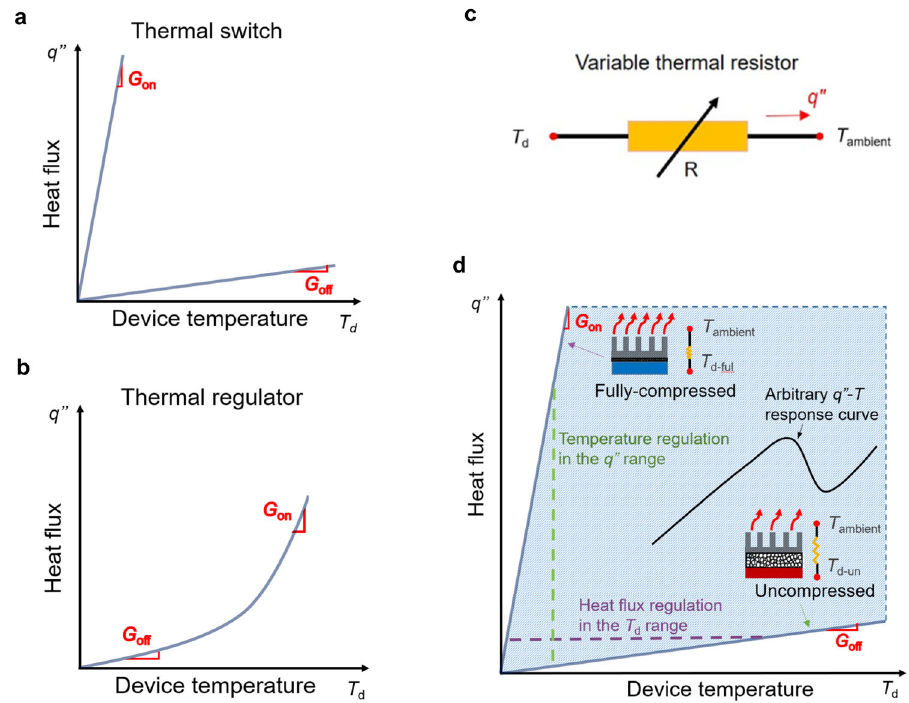
Fig. 1 Working principle of thermal devices in tradition and in this work. a A traditional thermal switch only has two possible thermal conductance states and b A traditional thermal regulator has a non-linear thermal performance curve and transitions from low to high thermal conductance passively based on device operating conditions. c Schematic of the variable thermal resistor concept. d Schematic showing the dual function of our device as both thermal switch and regulator as desired based on compressible graphene foam. The solid lines indicate the thermal performance in the “ on ” and “ off ” states (with the slopes being the thermal conductance of each state), and the shaded region indicates the region accessible with the continual tuning of the thermal conductance. As the power level or heat fl ux varies, the device temperature can be regulated through modulation of the foam thickness (along the dashed green, vertical line). Similarly, if a speci fi c heat fl ux must be regulated, the thickness of the element can be controlled as the temperature varies (along the dashed purple, horizontal line).